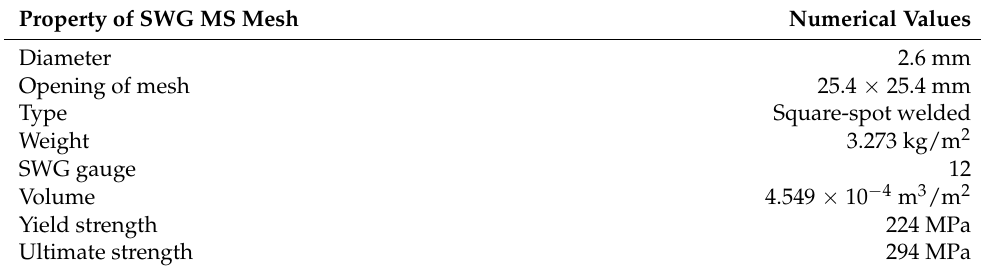
Table 4. Properties of steel wire